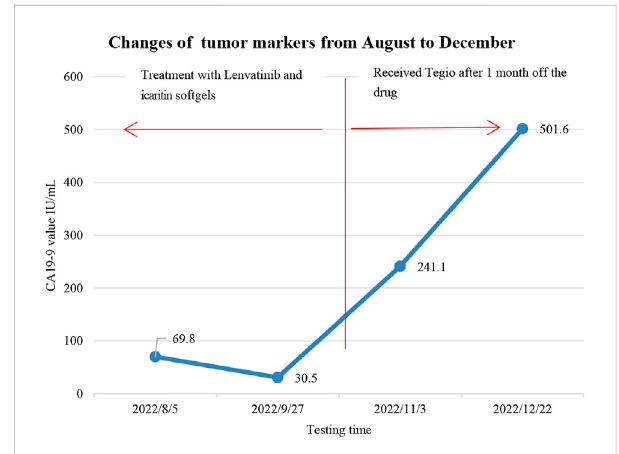
FIGURE 5 Changes in tumor markers: the patient took two drugs for 2 months between August and stopped them in early October for fi nancial reasons, later replaced them with Tegio in early November, and followed up about 3 months after the drug ’ s